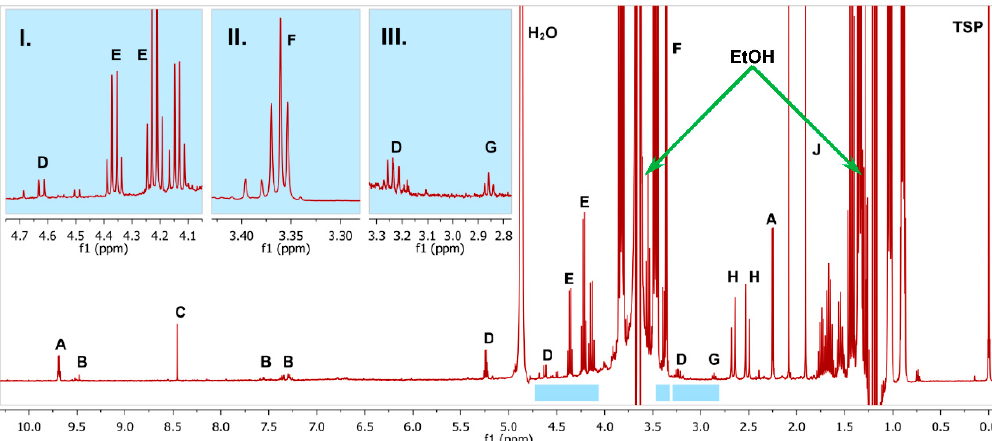
Figure 4. One-dimensional 1 H NMR Spectrum of whisky spiked with several of the analytes. I , II , III : enlargements, see the blue bars under the main spectrum for the regions. The labelled signals are: A: acetaldehyde, B: HMF (positive, < LOQ: limit of quantification), C: formic acid, D: glucose, E: ethyl lactate, F: methanol, G: 2-phenylethanol (positive, < LOQ), H: citric acid, J: acetic acid, H 2 O: water (suppressed), TSP: trimethyl silylpropionate-d4; EtOH: ethanol (suppressed).